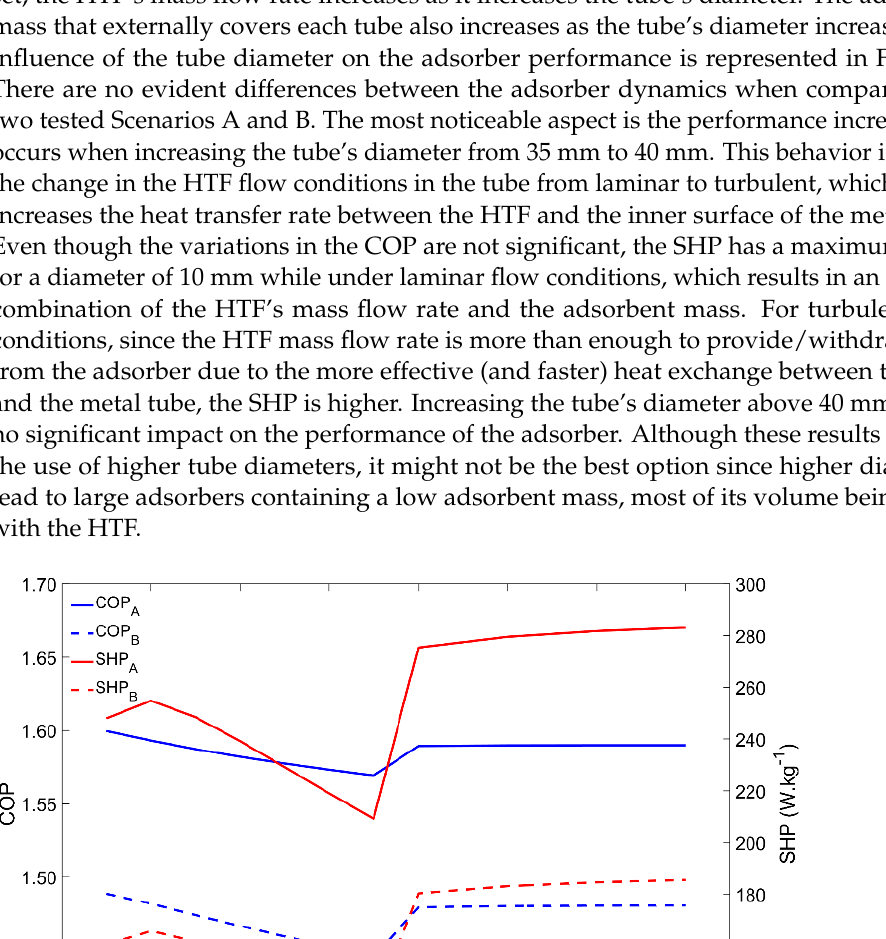
Figure 10. Influence of the heat transfer fluid’s velocity on the adsorber performance for scenarios A and B. 5. Adsorption Heat Pump System The design of an AHP system suitable for space and domestic water heating is pro- posed, which contains the coated tube adsorber described and studied above and also the following main components: evaporator, condenser, heating element, water reservoir, ex- pansion valve, centrifugal pump and the control valves. A condenser is placed inside the hot water reservoir, in this particular case the heating element is a natural gas burner; however, any other heating element can be used under the condition that heat is provided